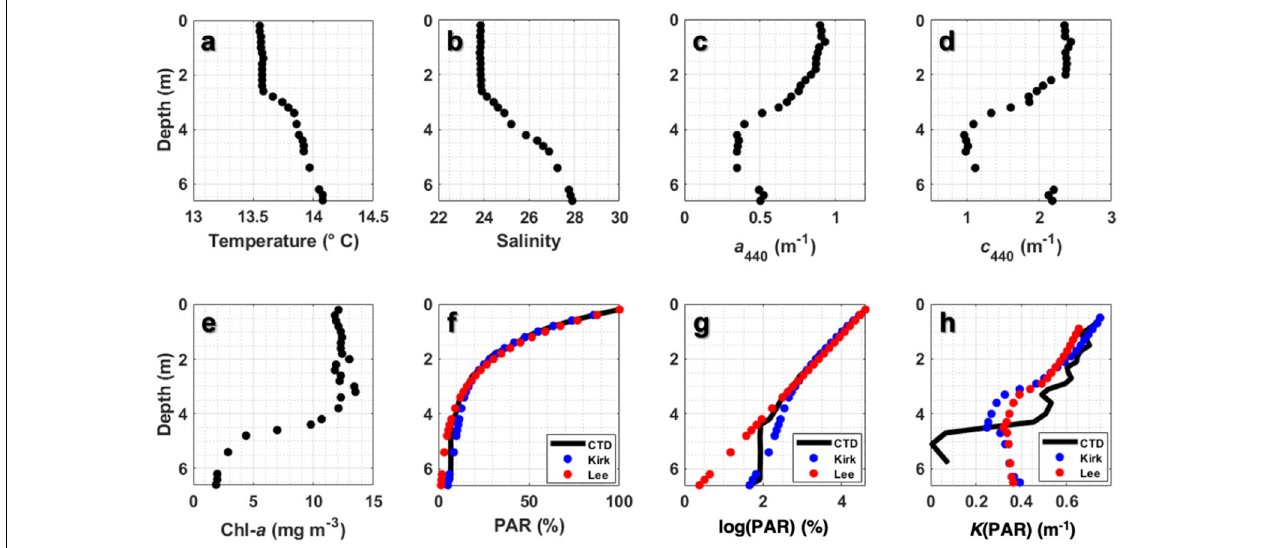
FIGURE 3 | Example of vertical profiles of environmental parameters for a shallow sampling station (number 2) visited on 19 Oct. 2017: (a) temperature ( ◦ C); (b) salinity; (c) a 440 (m – 1 ); (d) c 440 (m – 1 ); (e) Chl-a fluorescence (mg m – 3 ); (f) PAR (%); (g) log(PAR); (h) apparent K (m – 1 ) obtained for every 1-m